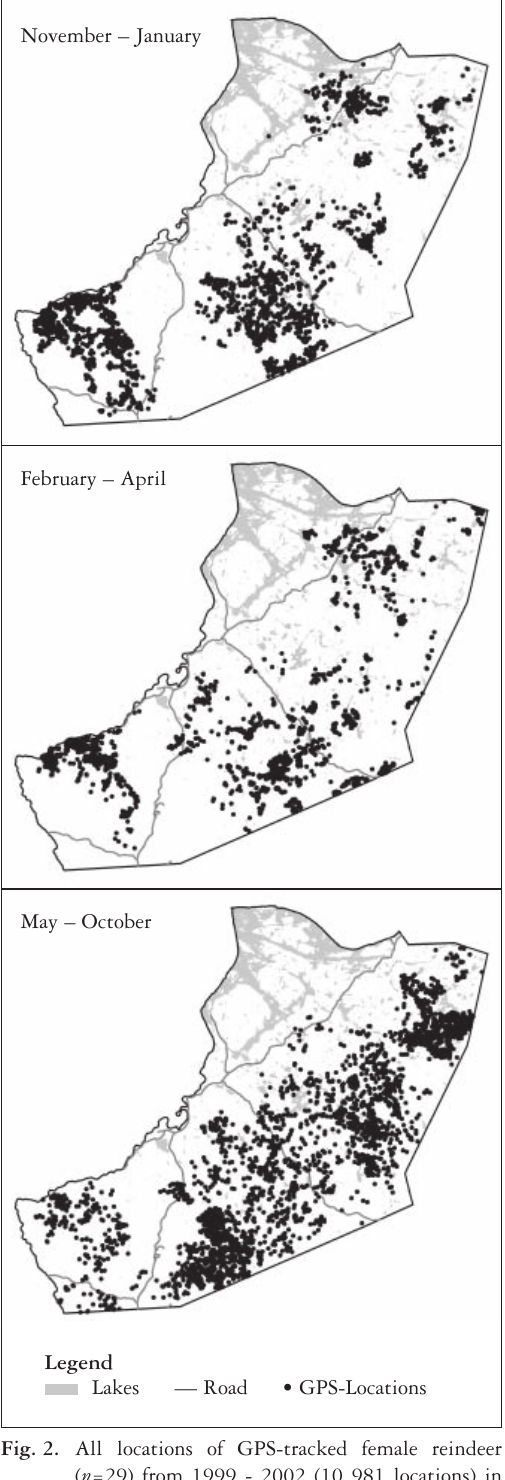
Fig. 2. All locations of GPS-tracked female